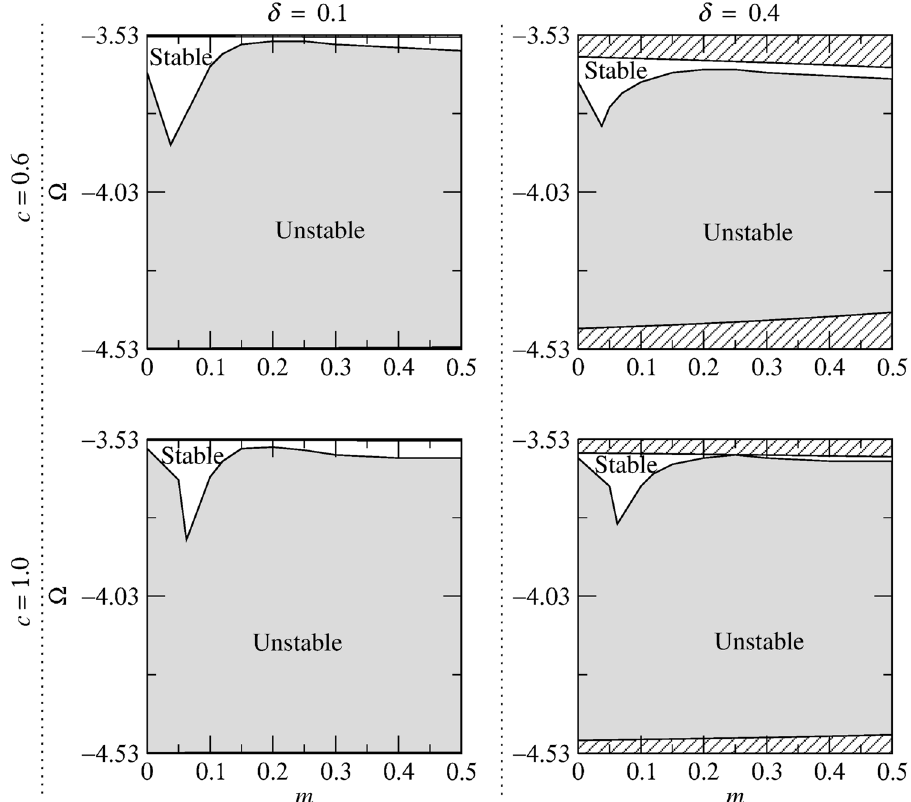
Figure 5. Stability regions corresponding to the lower gap in the ( m , Ω) plane for different values of soliton velocity (increasing δ from left to right) and relative group velocity (increasing c from top to bottom) for κ = 4. The areas which lie outside the gap and consequently do not contain soliton solutions are shown by the diagonal lines.